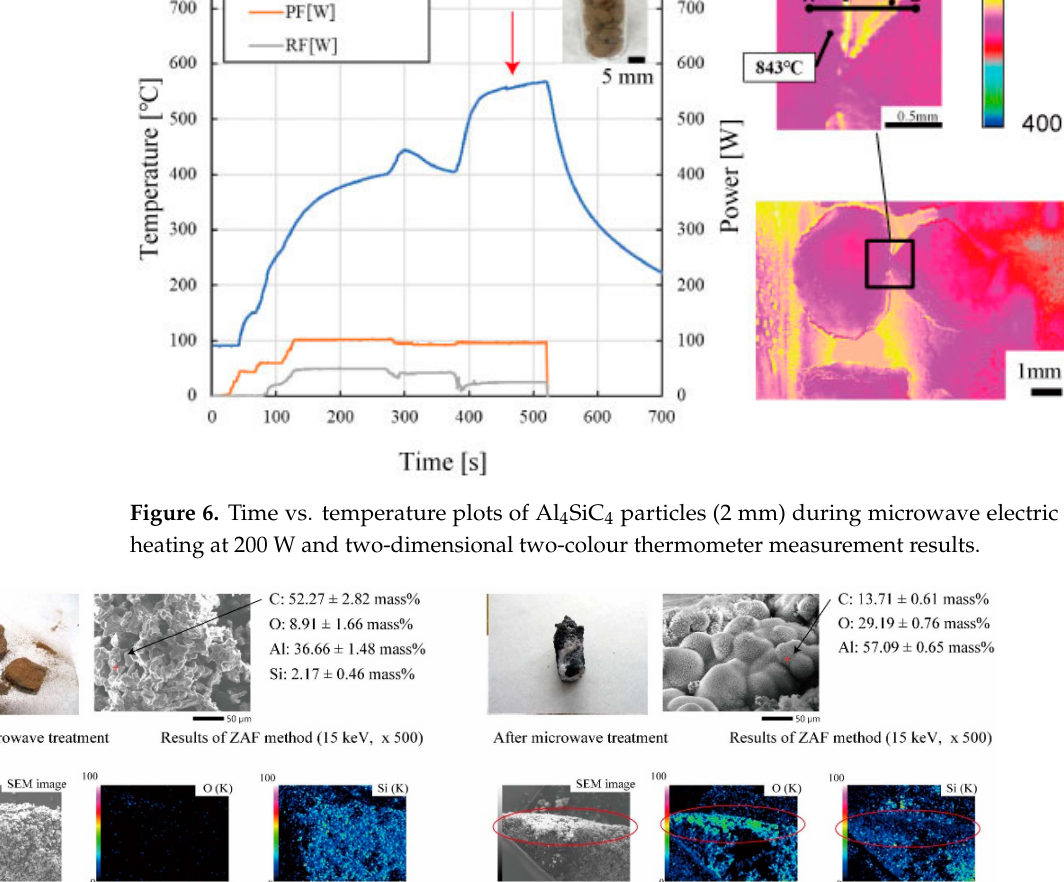
Figure 7. SEM-EDX images and analysis of Al 4 SiC 4 ( a ) before and ( b ) after microwave heating (dry air, 1000 ° C, 10 min). Remarkably, more Si seemed to evaporate during heating than Al. Because Al has a lower ionisation energy than Si, Al has a higher probability of plasma ionisation in the presence of an electric field. However, the SEM analysis indicates that Si may have evaporated, which implies that the evapora- tion of the interfacial elements follows a thermodynamic mechanism.